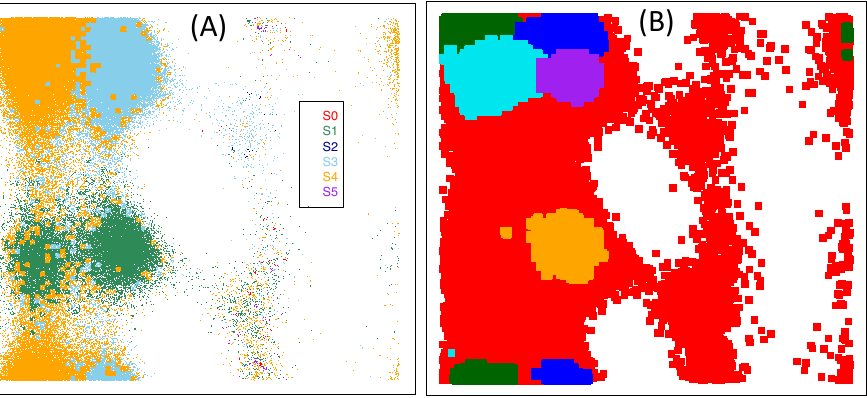
Figure 5. Clustering results of the alanine dipeptide from MPP ( A ) and MVCA ( B ). The axis is the same as that in Figure 3. Different colors in the figure present different